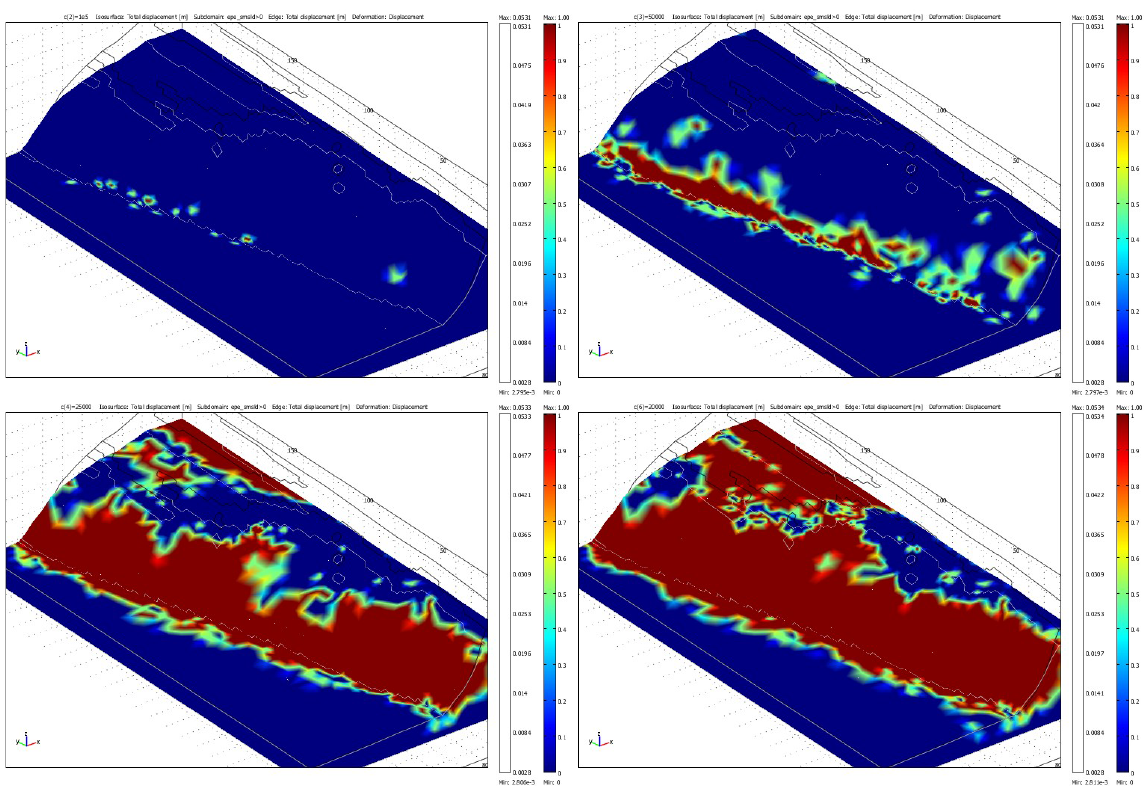
Fig. 14. 3-D Stability model. Parametric analysis on cohesion. The parametric analysis on cohesion emphasizes a progressive buckling starting from the foot of the slope area; it highlights the negative role on the stability carried out by the cavities. Using a finite element method, as well as shown in Fig. 11 using a finite difference method, it is not possible to evaluate the post-collapse behavior, because the computing system becomes